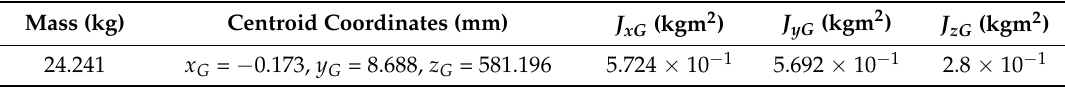
Table 11. Pico-satellite parameters in solidworks.